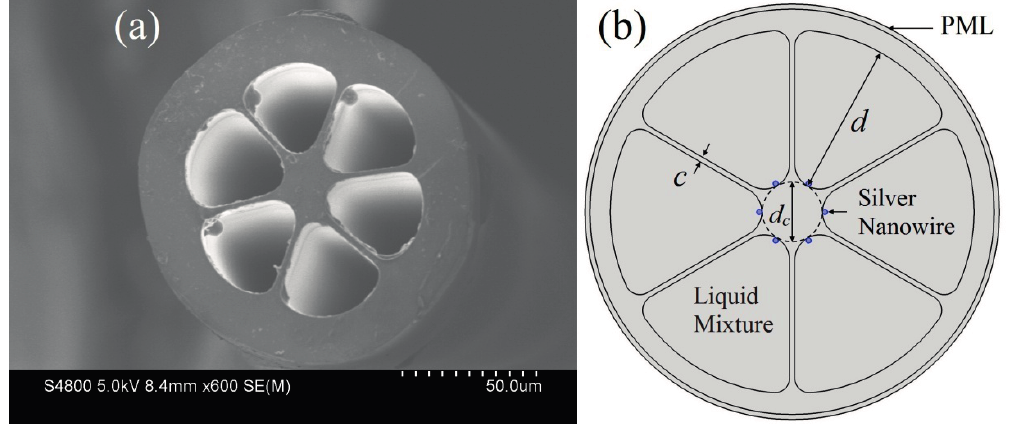
Figure 1. ( a ) Cross-section image of a six-hole PCF; ( b ) Schematic of the proposed sensor fiber. The silver nanowires indicated by megascopic blue dots. Parameters c , d denote the thickness the core strut, the diameters of the core and the holes,